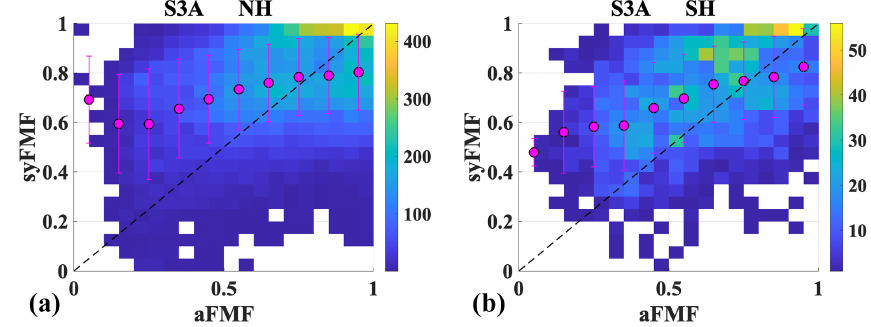
Figure 20. Density scatter plots for S3A syFMF and corresponding aFM for collocations available over the NH (a) and SH (b) .